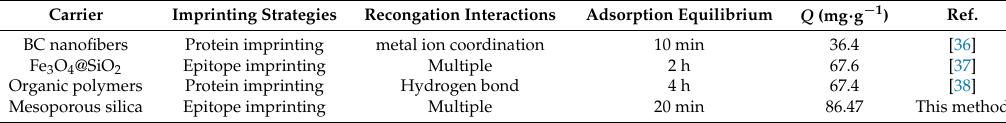
Table 4. Comparison of different methods of imprinting Cyt c.